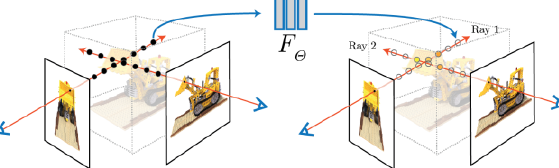
Figure 1 . Diagram of how the Nerf rendering process works (image taken from” NeRF: Representing Scenes as Neural Radiance Fields for View